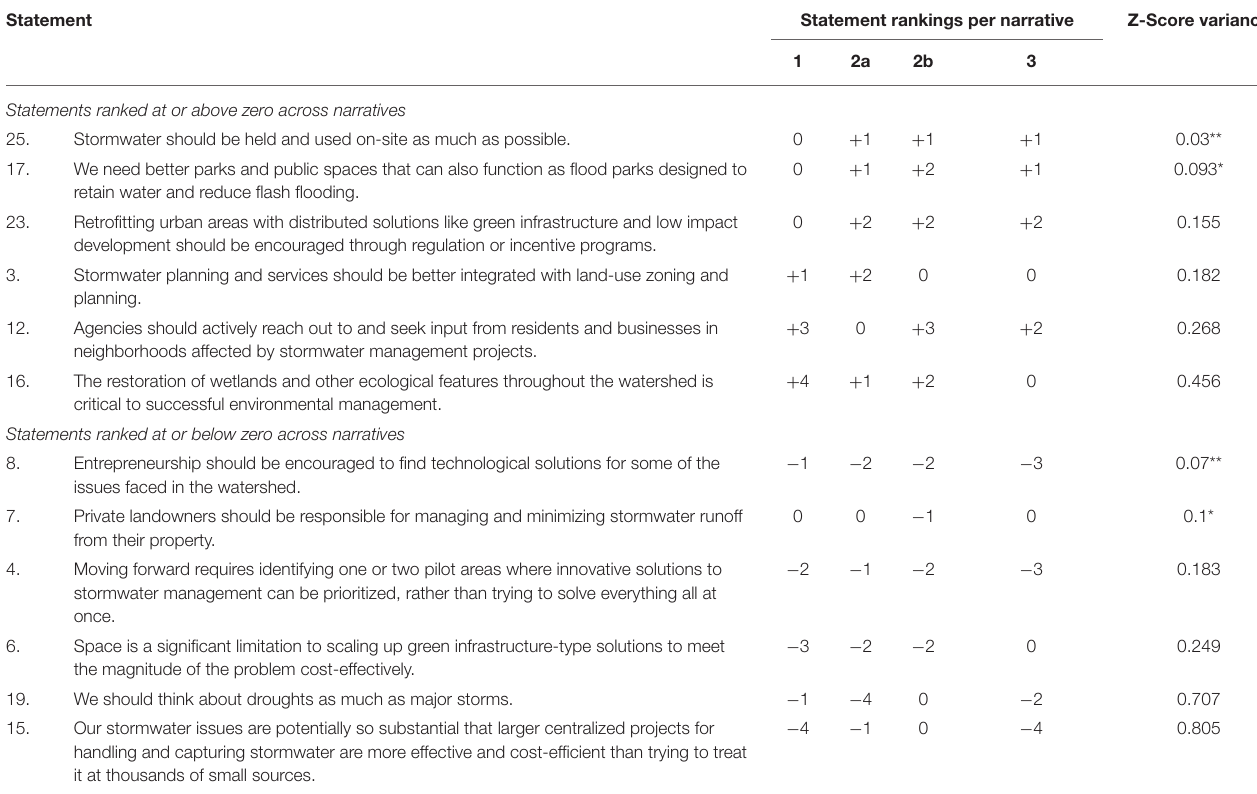
TABLE 8 | Statements by Z-score